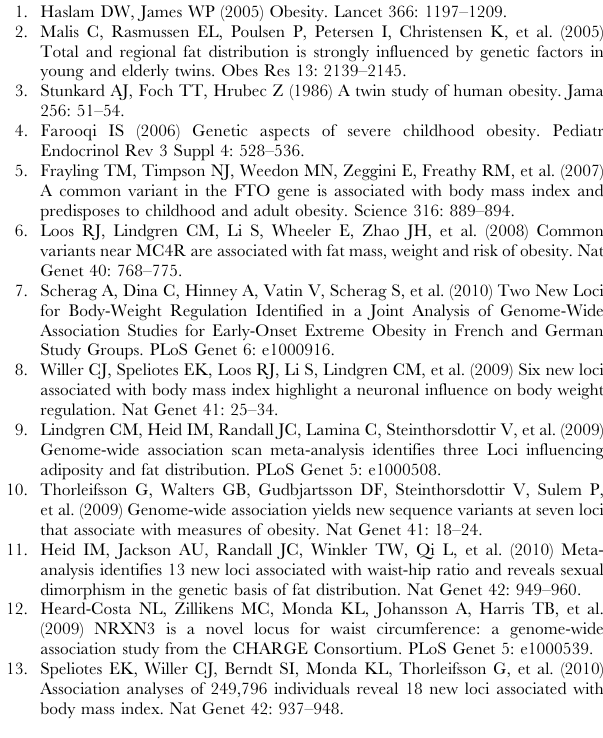
Figure S2 Multi-dimensional scaling (MDS) of the SNP genotyping data for samples with whole-genome genotypes, with (left panel) or without (right panel) 30 Asian, 30 African American and 30 Caucasians to seed the graph. A total of 70,593 SNPs not in LD (r 2 , 0.2) and not in sex chromosomes were used in the MDS analysis. All GWAS samples were of genetically inferred European ancestry. Figure S3 The quantile-quantile (QQ) plot of the association results for the GWAS on obesity. The genomic control inflation factor was 1.05. Table S1 Examination of BMI-associated genes in our data set for association with quantitative traits in cases and controls, adjusting for obesity